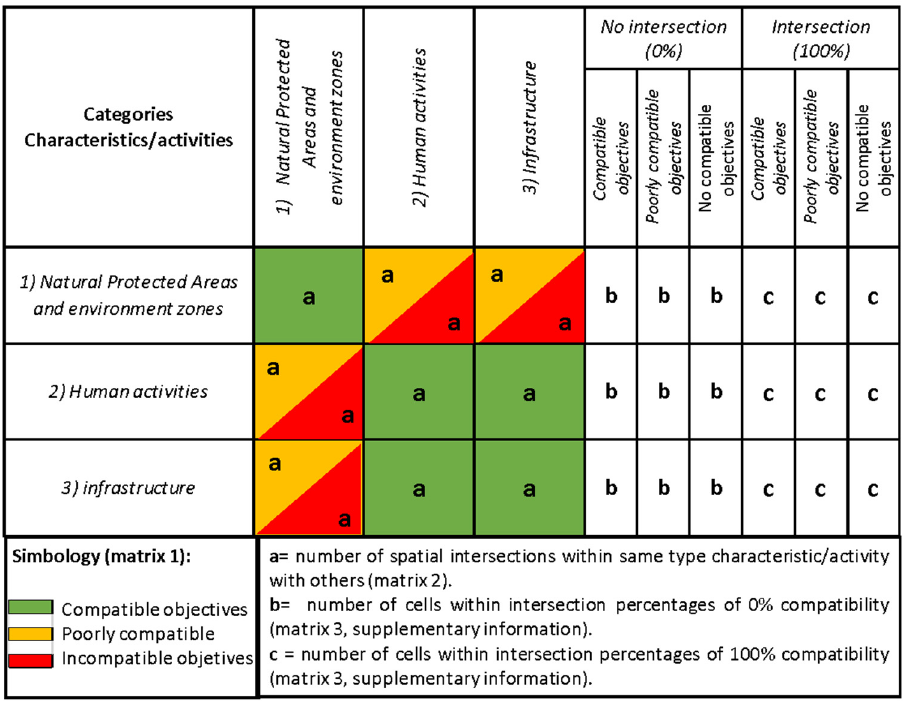
Figure 4. Summary of matrices that show the degree of compatibility between the characteristics/activities objectives in the Mexican Caribbean represented by colors: green for compatible, orange for poorly compatible and red for incompatible objectives (matrix 1). Number of spatial intersections (matrix 2), and number of cells with intersection percentages of 0 and 100% (matrix 3 in supplementary materials).